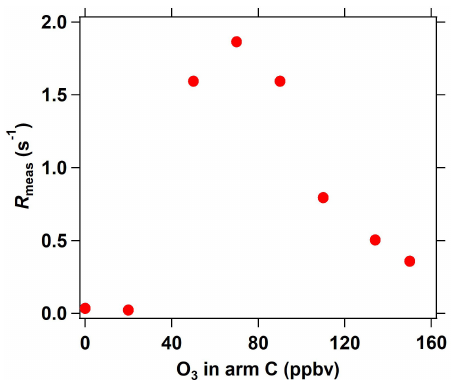
Figure 6. Interference of different O 3 concentrations (introduced into the reactor through arm C) on measured OH reactivity in the ICRM